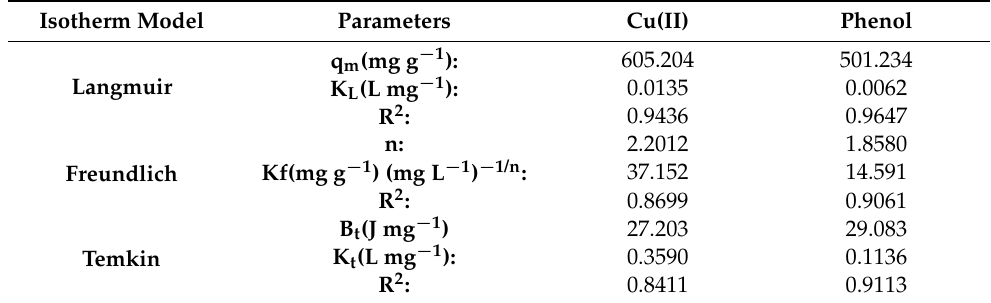
Table 2. Adsorption isotherm parameters for Cu(II) and phenol onto PANI@WTP